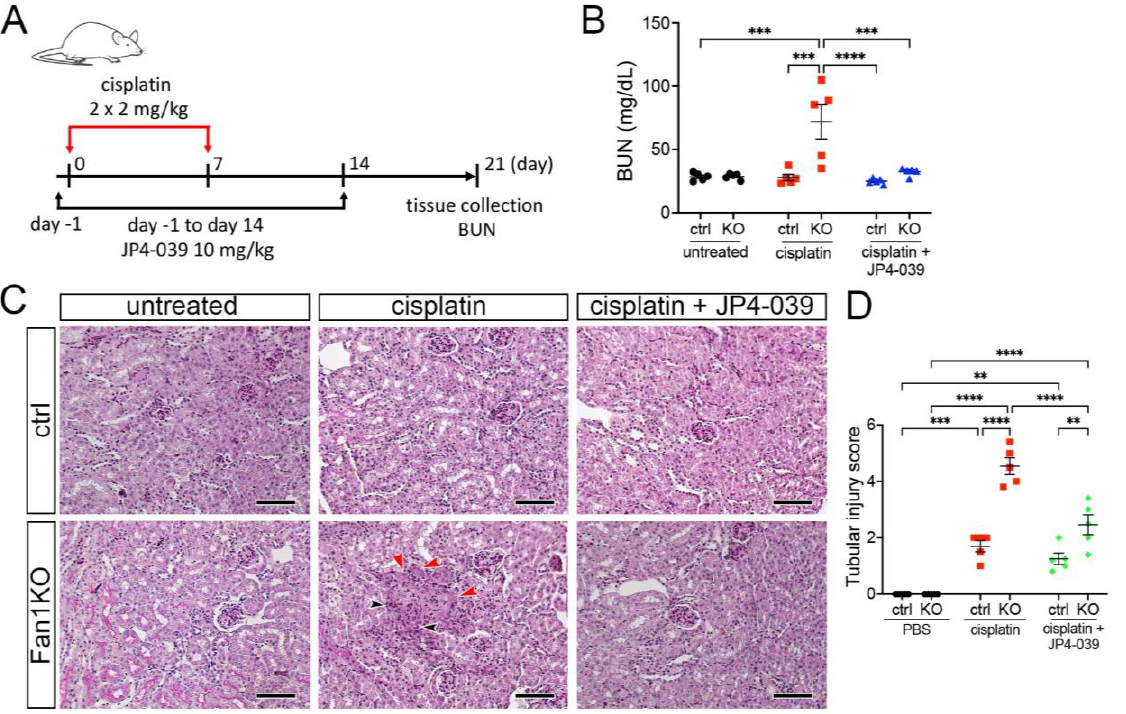
Figure 4. DNA damage causes aberrant cell cycle activity in FAN1-null kidneys. ( A ) Mice received 2 doses of intraperitoneal (i.p.) cisplatin (2 mg/kg) vs. vehicle (normal saline) on days 0 and 7 and were treated with i.p. JP4-039 (10 mg/kg in 50% PEG-400/50% H 2 O) vs. vehicle (50% PEG-400/50% H 2 O) 1 day prior to and until day 14 after the first cisplatin injection. Tissues were collected for analysis 21 days after the first cisplatin dose. ( B ) Blood urea nitrogen (BUN) measurements in ctrl and FAN1-null mice show loss of kidney function in FAN1KO mice after induction of KIN. *** p < 0.001, **** p < 0.0001, n = 5 each. ( C ) Histological analysis of kidney sections by Periodic acid– Schiff (PAS) staining demonstrates the formation of KIN in FAN1KO mice, characterized by tubular atrophy, formation of karyomegalic nuclei (red arrowheads), and segmental basement membrane thickening (black arrowheads) in the proximal tubules. Scale bars: 50 µ m. ( D ) Tubular injury scores in control mice were compared with those in FAN1KO kidneys after low-dose cisplatin administration. ** p < 0.01, *** p < 0.001, **** p < 0.0001, n = 5 each. ( B , D ) Data are presented as the mean ± SEM. A two-way ANOVA with Tukey’s post hoc